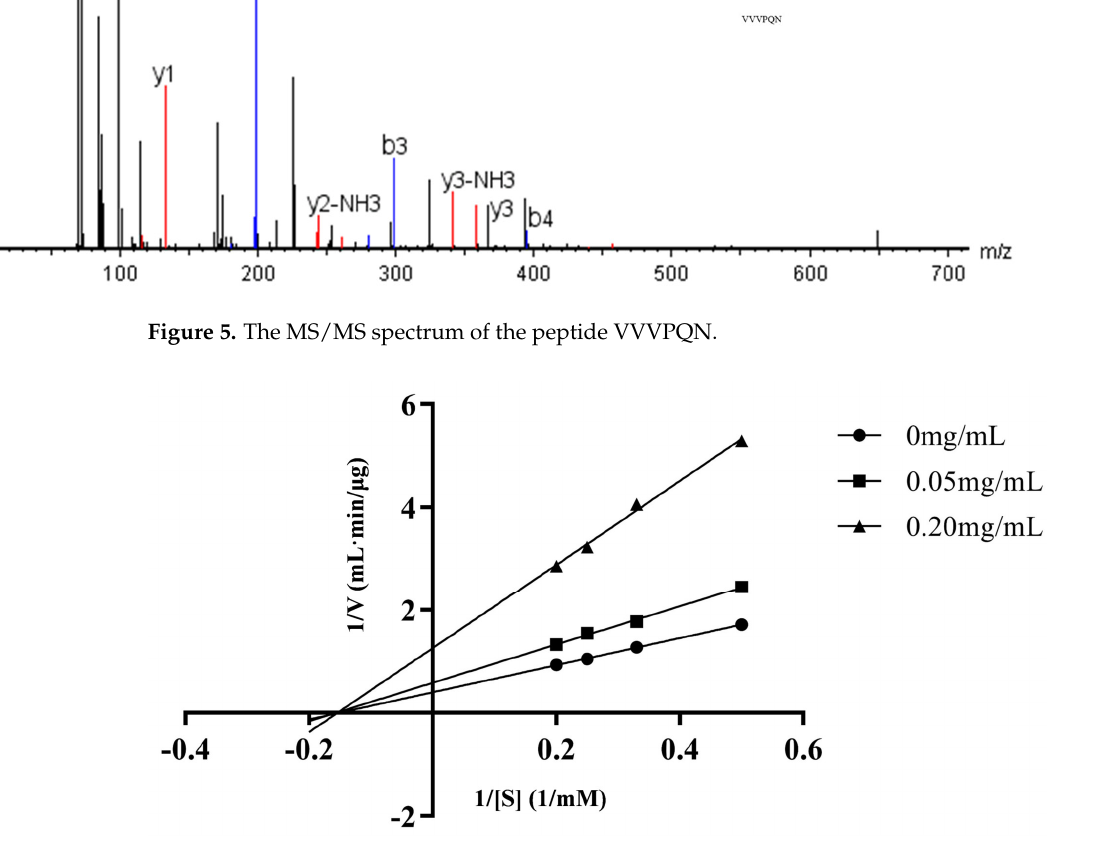
Table 2. Kinetic parameters of VVVPQN binding with ACE in different concentrations.